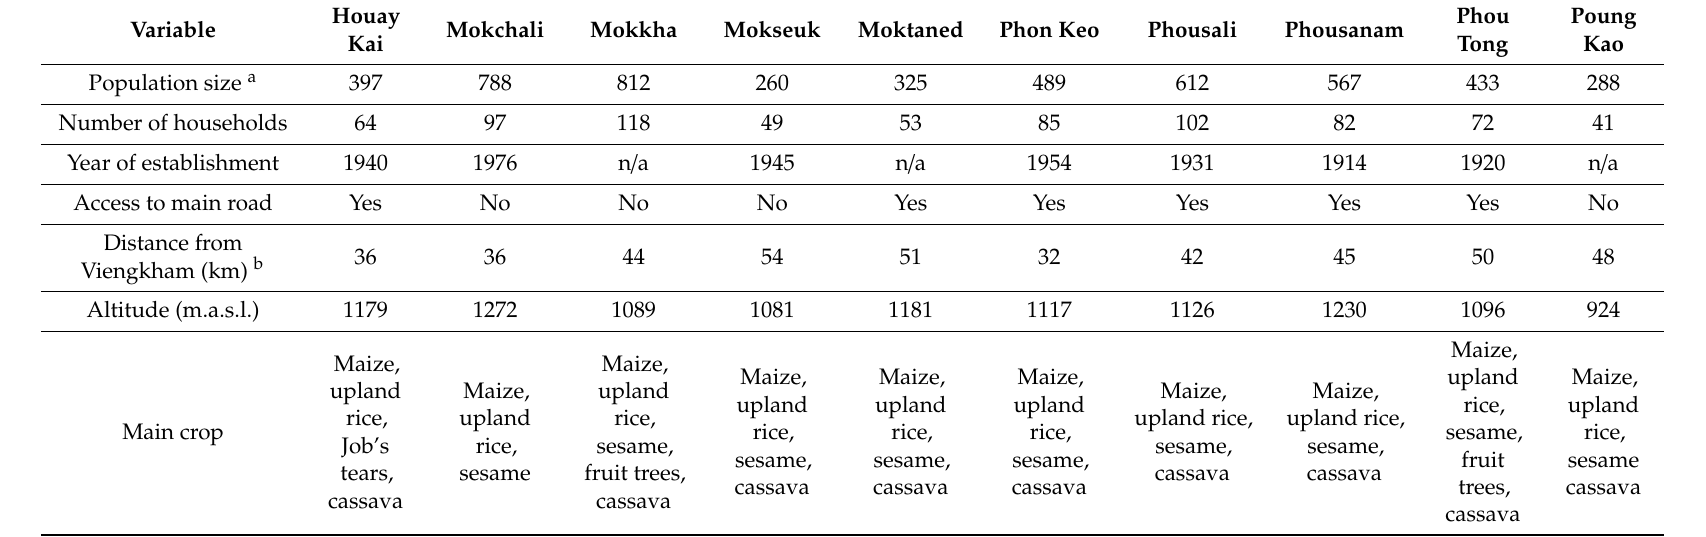
Table 1. Characteristics and major production activities of the studied